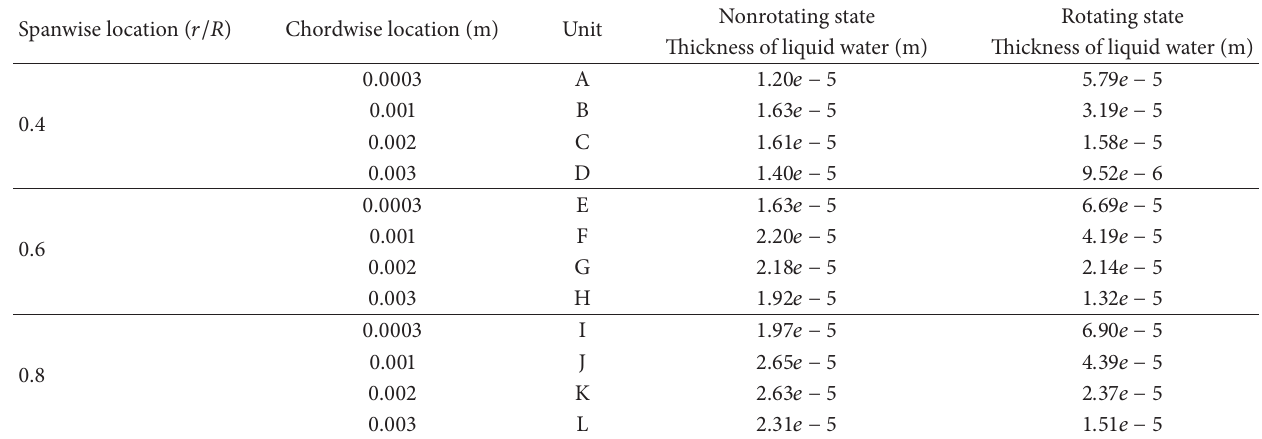
Figure 8: Liquid water distributions in the nonrotating/rotating state. Table 3: Liquid water distribution in each